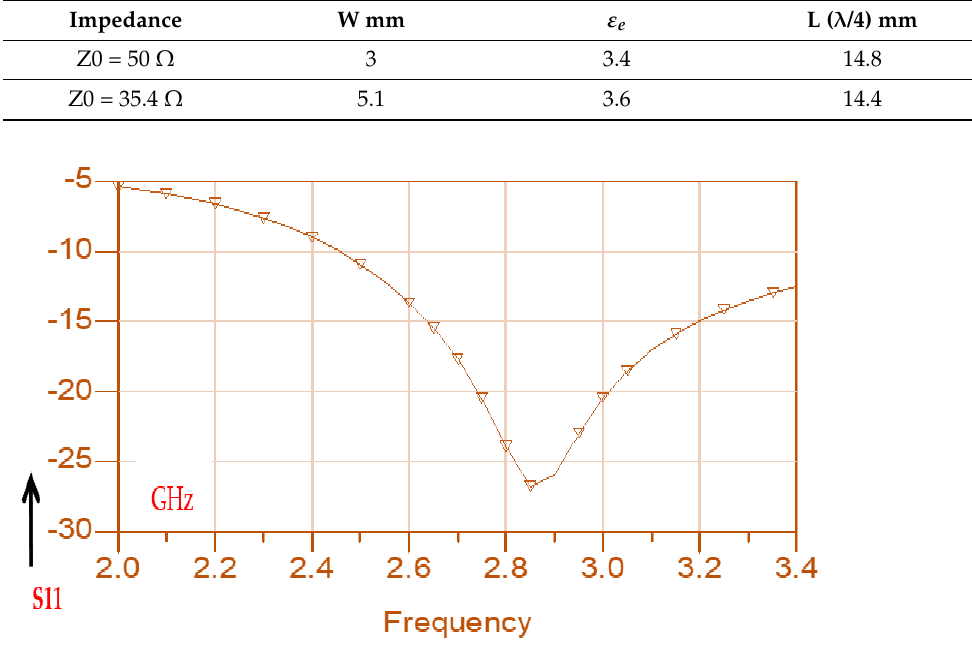
Figure 5. The branch line coupler reflection coefficient, S11.